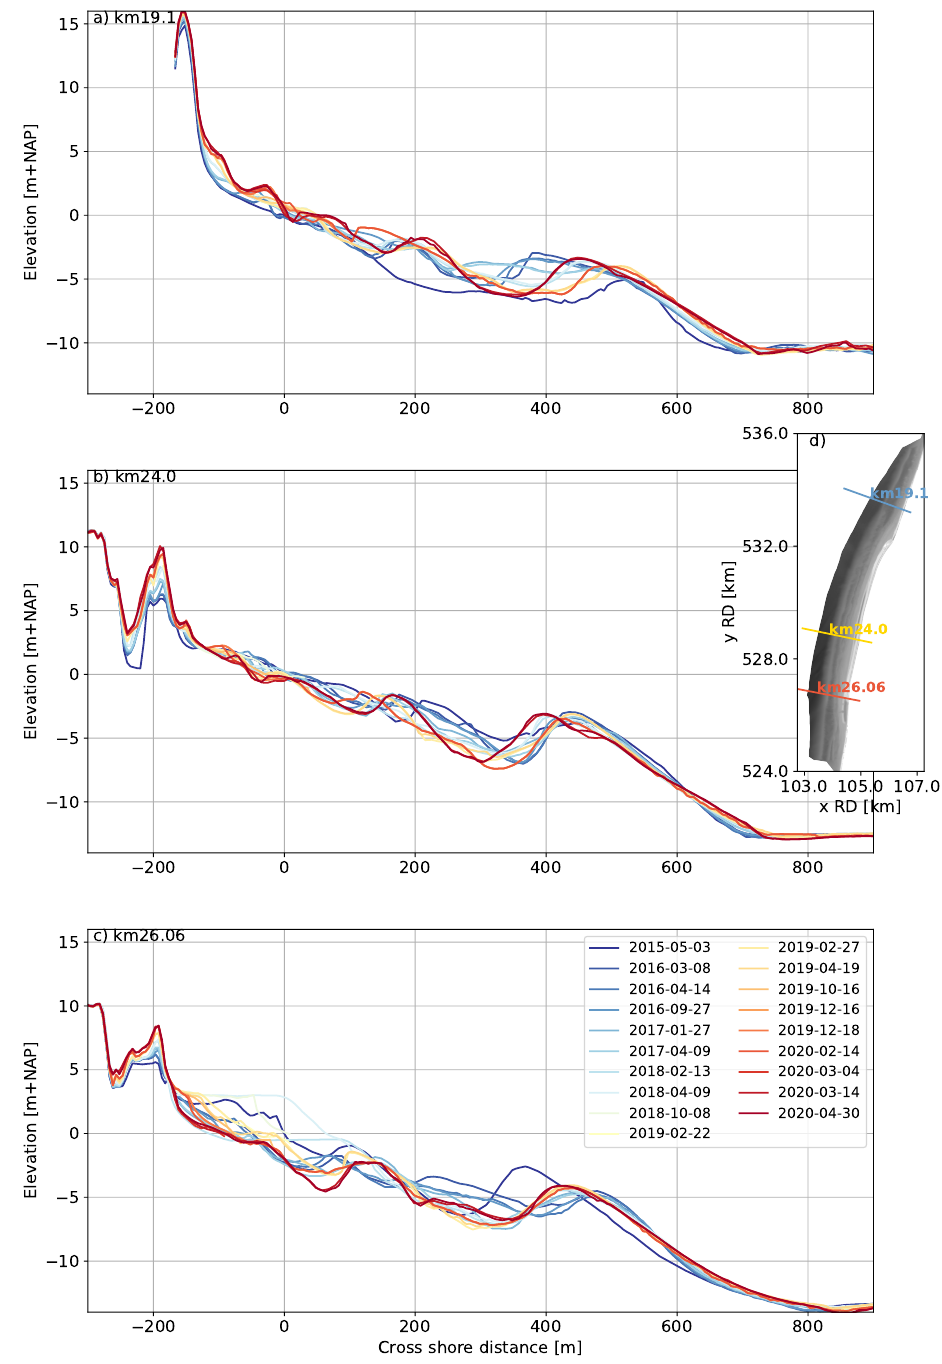
Figure 6. Bed levels on three cross-shore transects. ( a ) Northern transect at km 19.1. ( b ) Central transect at km 24.0. ( c ) Southern transect at km 26.06. Colors show the different surveys in time. ( d ) the location of the transects in plan view. 0 m + NAP is approximately